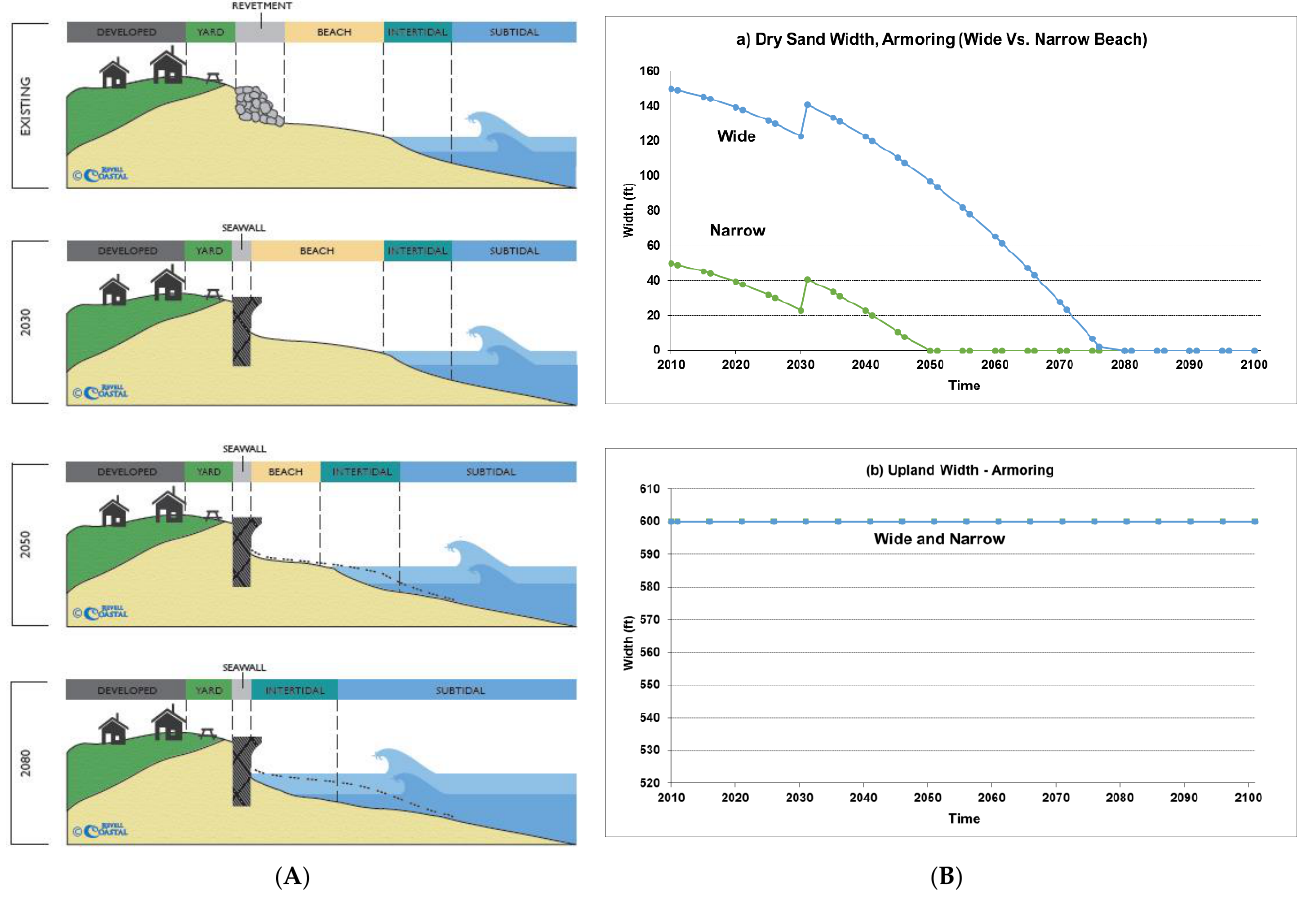
Figure 8. ( A ) Evolution of the armoring adaptation strategy, showing a small increase in usable beach as the existing revetments are replaced with vertical seawalls, then the loss of dry and eventually intertidal sand beaches over time. ( B ) Dry sand beach width over time with armoring (wide vs. narrow beach) (Ba top plot); upland width over time with armoring (wide vs. narrow beach) (Bb bottom plot).